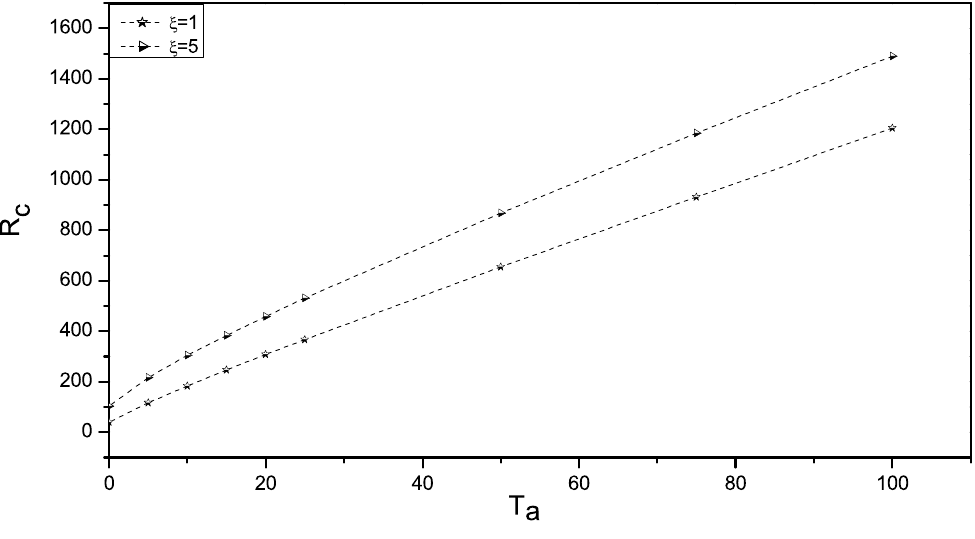
Figure 3. Critical Rayleigh number R c as function of T a , for ξ = 1,5. Table 1. Critical values of Rayleigh number R c , vs. ξ , for ˜ T 2 = 5,10,15,20,25.